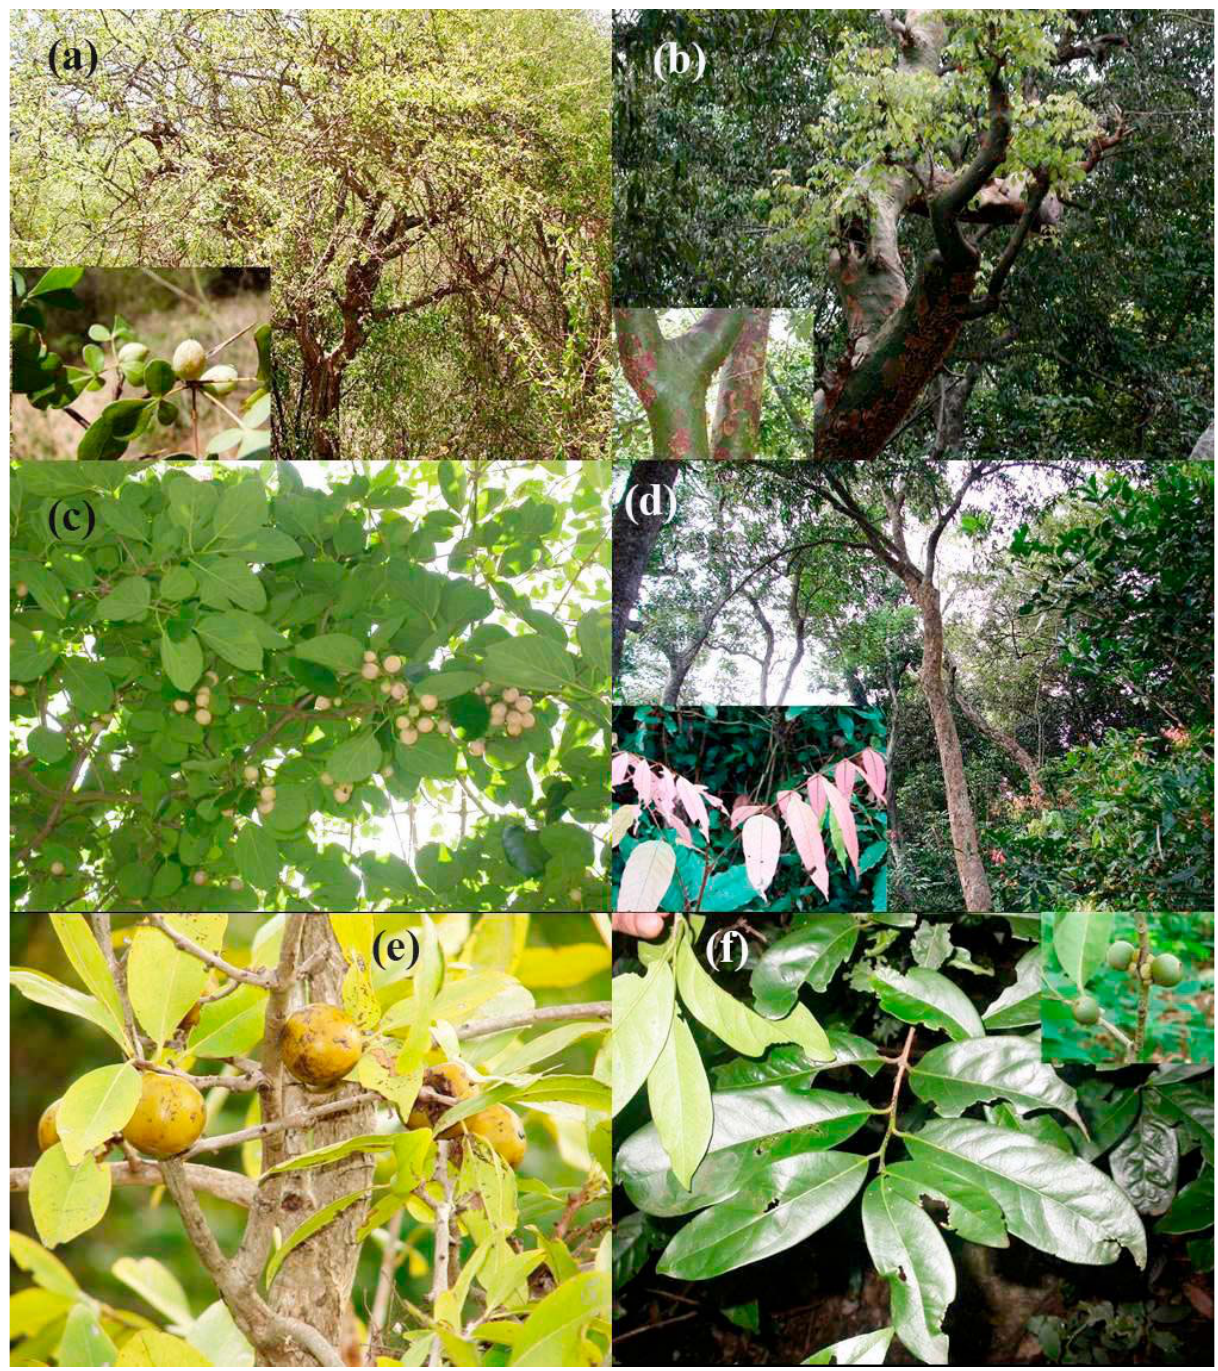
Figure 8. a) Commiphora berryi (Burseraceae); b) Commiphora caudata (Burseraceae); c) Cordia obliqua (Cordiaceae); d) Dimocarpus longan (Sapindaceae); e) Diospyros melanoxylon (Ebenaceae); f) Diospyros ovalifolia (Ebenaceae). Photo by L. Arul